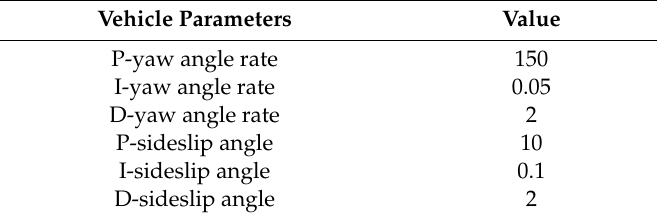
Table 6. Main parameters of PID control model of